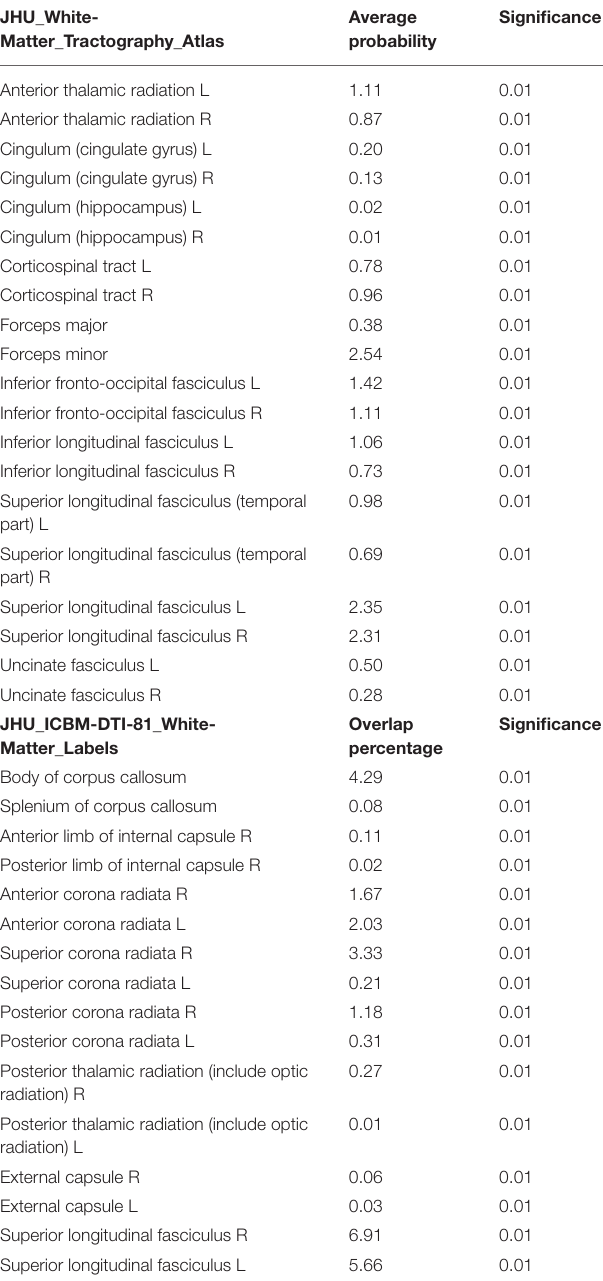
TABLE 2 | TBSS results–JME vs. healthy